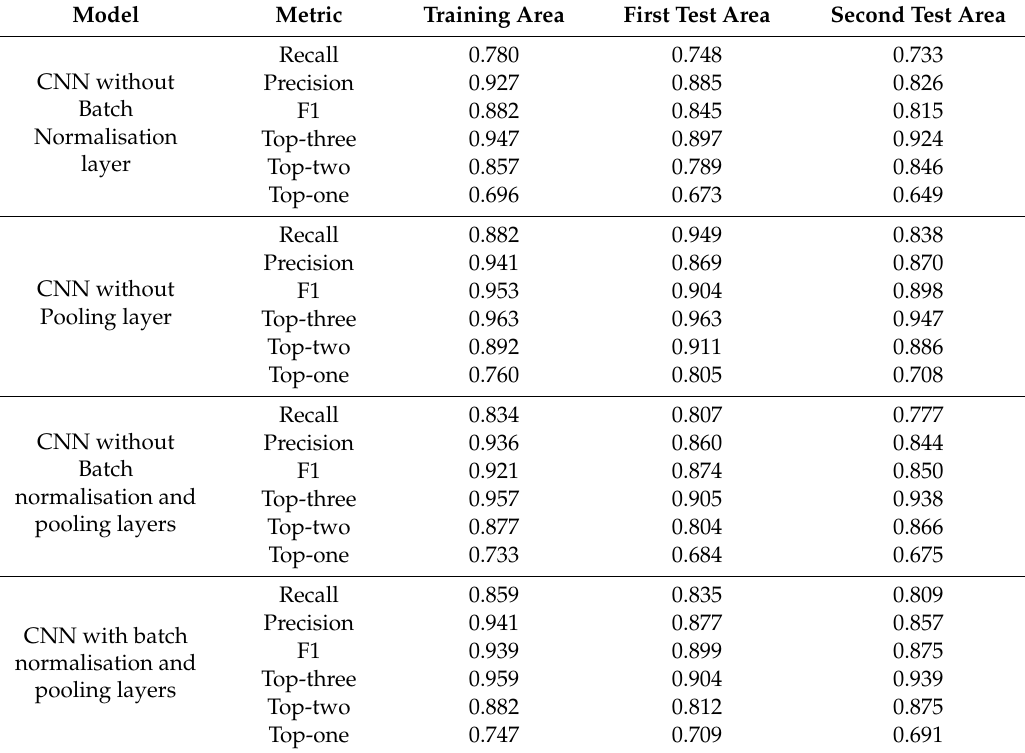
Table 2. The impact of various architectures applied to the first and second datasets.